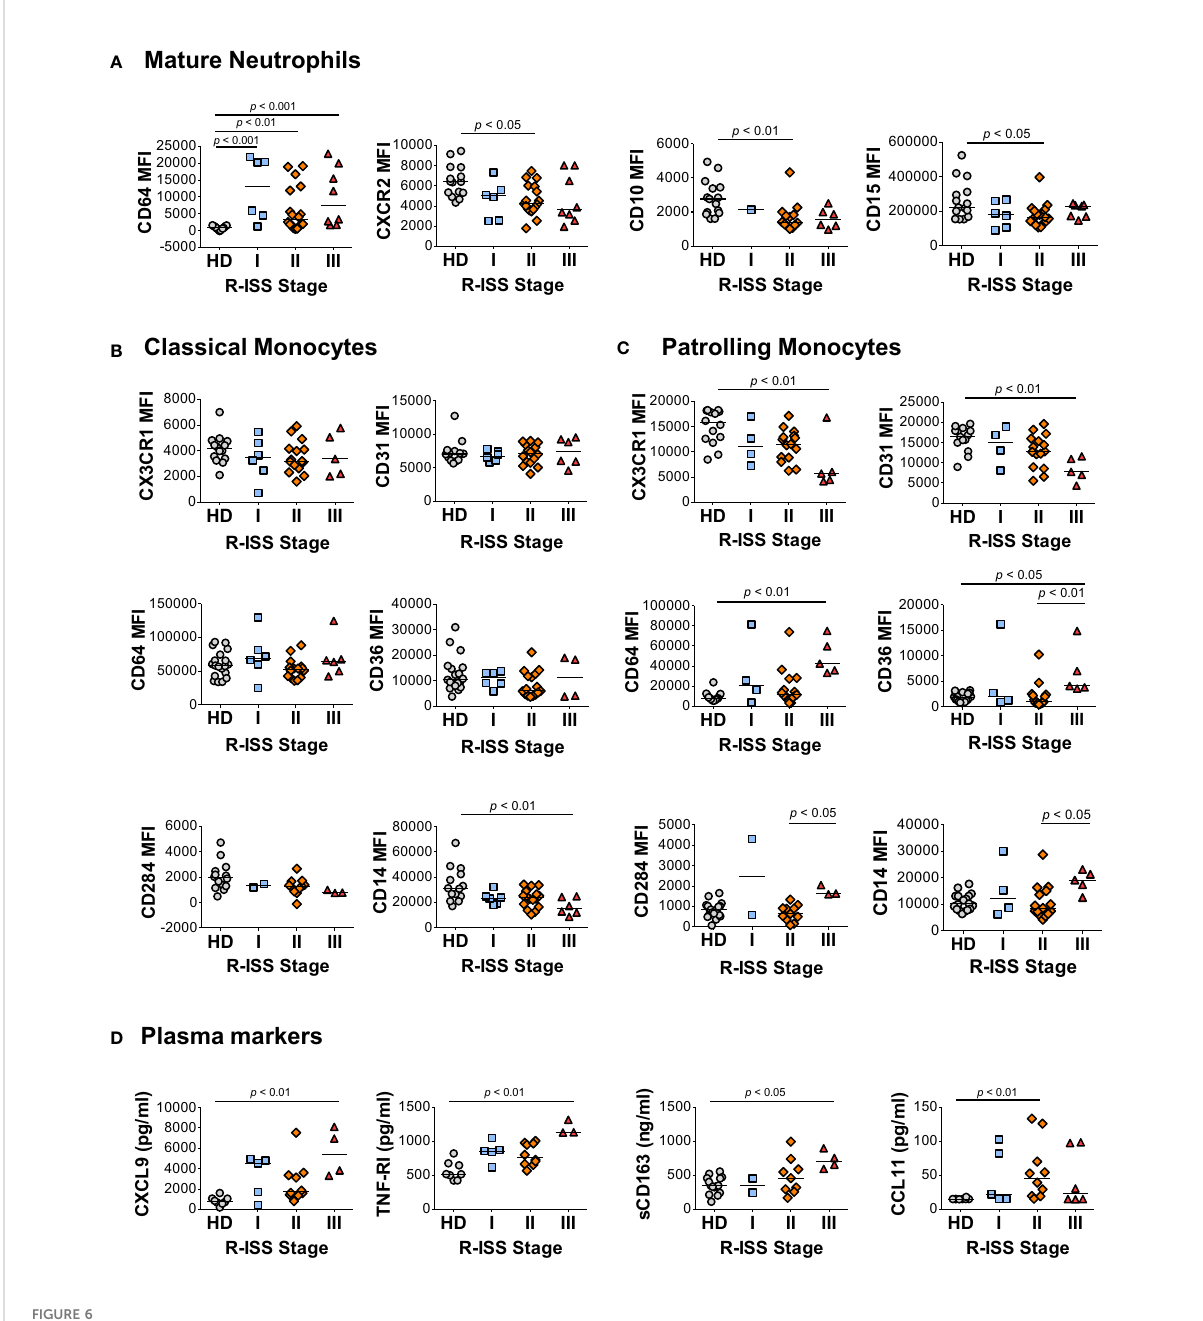
FIGURE 6 Characteristic features of the MM2 phenotype are associated with an advanced R-ISS stage. (A – C) Expression of surface markers on mature neutrophils (A) , classical monocytes (B) , and patrolling monocytes (C) strati fi ed using R-ISS. (D) Levels of cytokines and plasma markers of activation strati fi ed using R-ISS. MFI, median fl uorescent intensity; statistical analyses were performed using the Kruskal-Wallis one-way ANOVA test followed by Dunn ’ s post hoc test with p values as indicated. Bars represent median